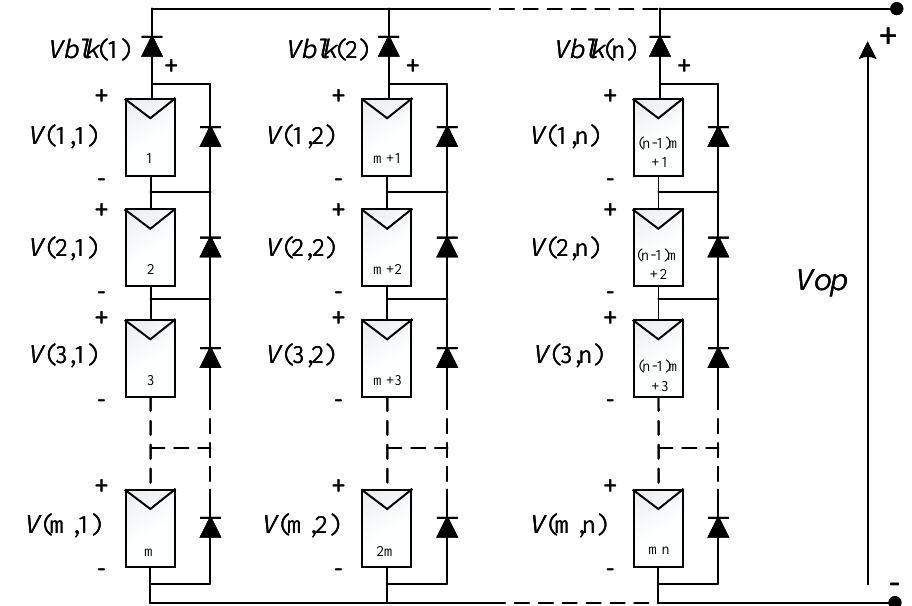
Figure 1. Nomeclature for the SP PV